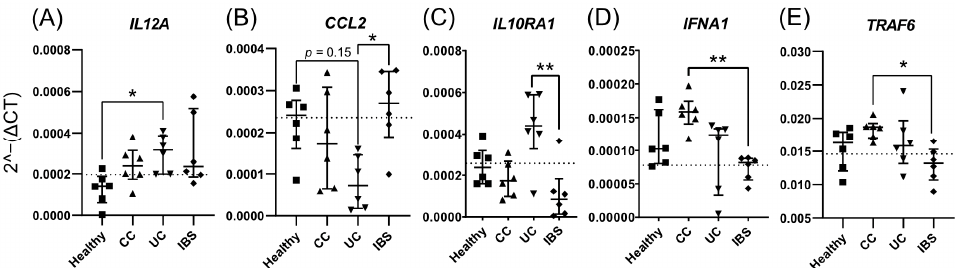
Figure 5. Comparison of gene expression of colonoids stimulated with fecal supernatants from healthy subjects and patients with colon cancer (CC), ulcerative colitis (UC) and irritable bowel syndrome (IBS). Apical-out colonoids were stimulated with fecal supernatants or media for 48 h. Gene expression of ( A ) IL12A , ( B ) CCL2 , ( C ) IL10RA1 , ( D ) IFNA1 and ( E ) TRAF6 was compared between healthy (square), CC (triangle), UC (inverted triangle) and IBS (rhombus). The dotted line indicates mean gene expression of untreated colonoids (n = 6). Statistical difference between the groups was assessed by the Kruskal–Wallis test, followed by Dunn’s multiple comparisons test. * p < 0.05; ** p < 0.01 (n = 6 for each group).